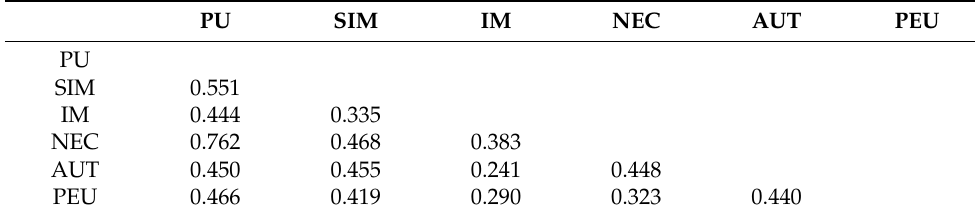
Table 7. HTMT analysis *.